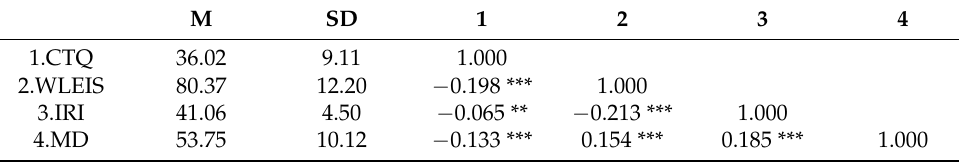
Table 1. Descriptive statistics and bivariate correlations for all measures.